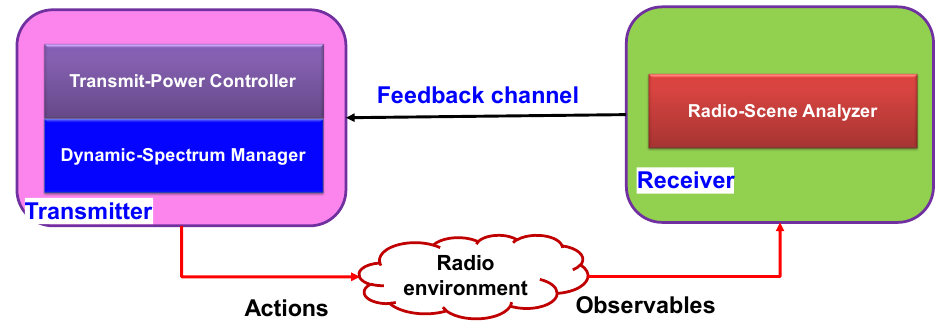
Figure 8. The cognitive-information-processing cycle in cognitive radio [29]. In summary, from the perspective of open access, spectrum sensing by the receiver